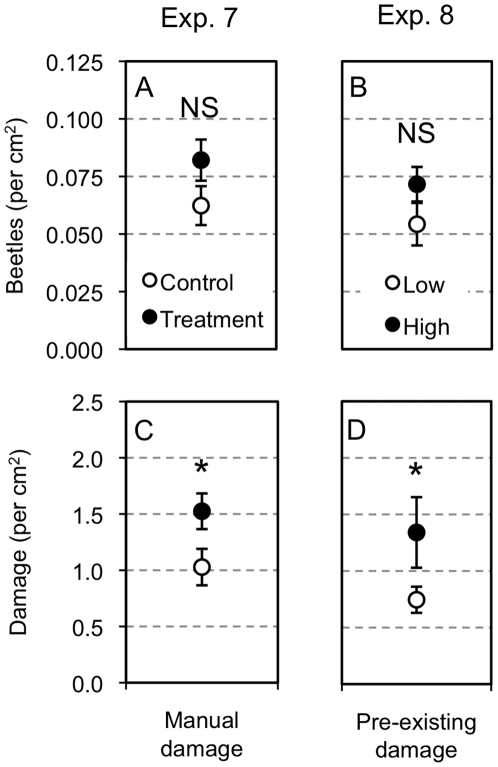
Effect of leaf damage on beetle choice and herbivory.Experiments 7–8 treatment means (± SE) number of beetles per cm2 (A,B) and damage per cm2 (C,D). Exp. 7 compares manually damaged leaves versus un-damaged control leaves (A,C). Exp. 8 compares leaves with high- versus leaves with low-pre-existing damage (B,D). Statistical differences between ant and control treatment means are represented as: NS = P>0.05, * = P<0.05, ** = P<0.01, *** = P<0.001.